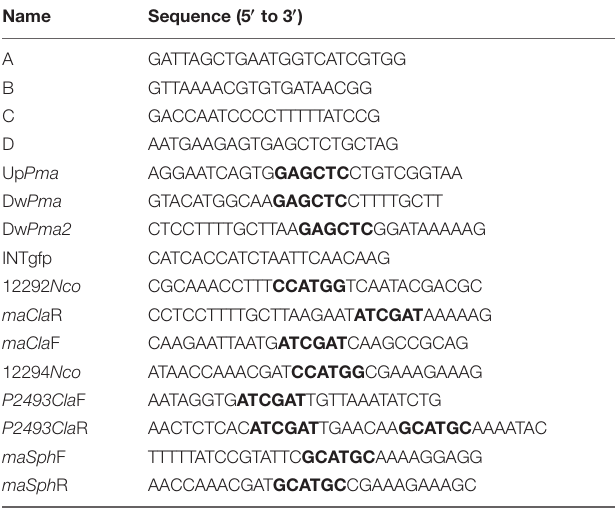
TABLE 1 | Oligonucleotides used in the construction of bacterial strains and plasmids, in RT-PCR assays and in primer extension